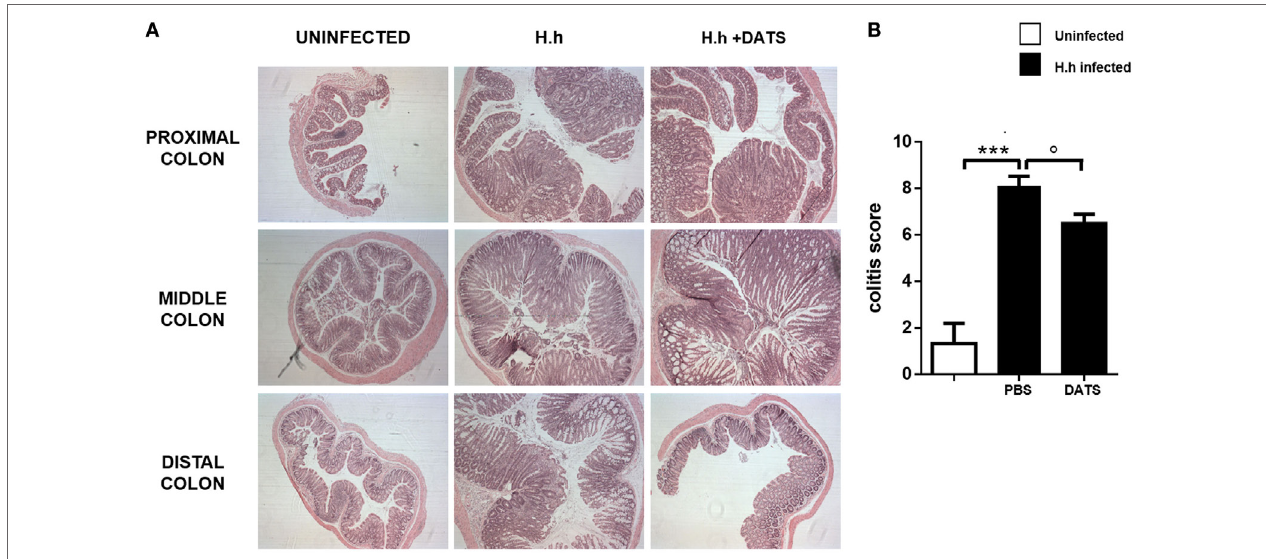
FigUre 3 | H 2 S donor reduces the severity of colitis. (a) Representative photomicrographs (magnification × 50) of H&E-stained proximal, middle, and distal colon isolated from healthy mice and from 6 weeks Helicobacter hepaticus -infected mice treated with DATS or only vehicle (PBS) and correspondent (B) inflammation score. DATS significantly reduced inflammation in the colon. Data are shown as mean ± SEM ( n = 5 per group) (*** P < 0.001 vs. uninfected. ° P < 0.05 vs.